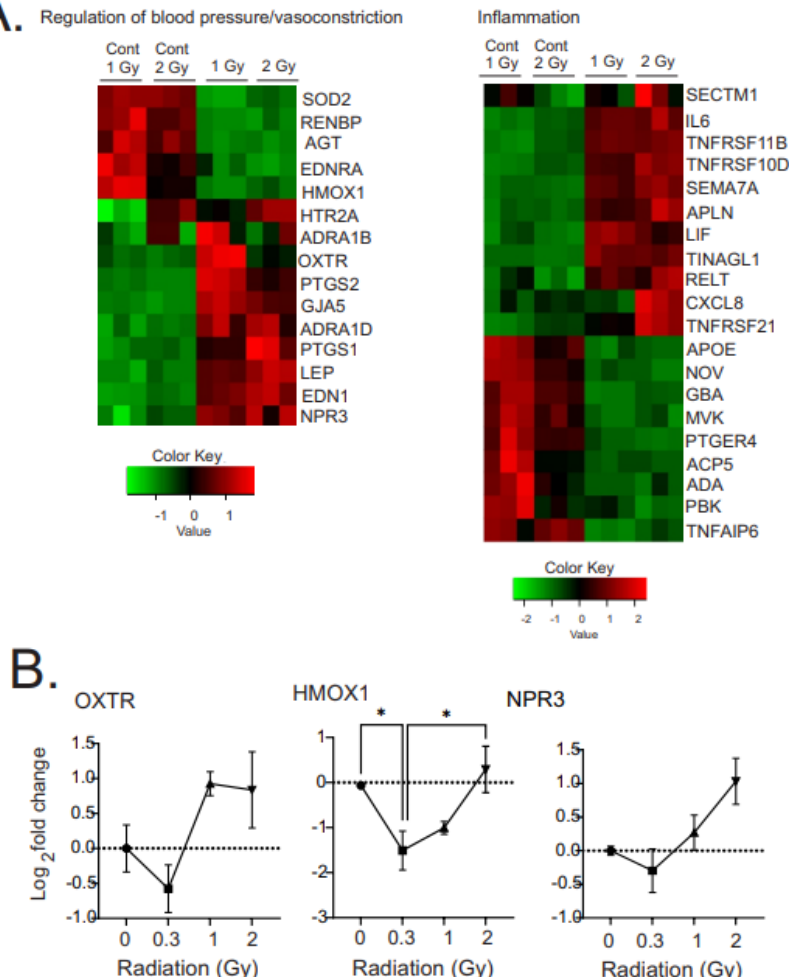
Figure 8. Heatmaps of gene expression changes for pathways involved in the regulation of blood pressure or vasoconstriction and inflammation. ( A ). RNAseq was used to identify gene expression changes in primary human MSCs following 1 or 2 Gy (0.66 cGy/h) 60 Co irradiation. Control cells were cultured under identical conditions for 1 or 2 weeks. GO analysis was performed using DAVID and heatmaps were generated using genes with q < 0.05. Rows are centered and unit variance is applied to rows. ( B ). qPCR gene regulation using log base 2 scale fold change of genes supporting heatmaps of pathways. Data show averages ± SEM from N = 3 biological replicates with two technical repeats. * indicates p < 0.05 compared with sham-irradiated control cells.